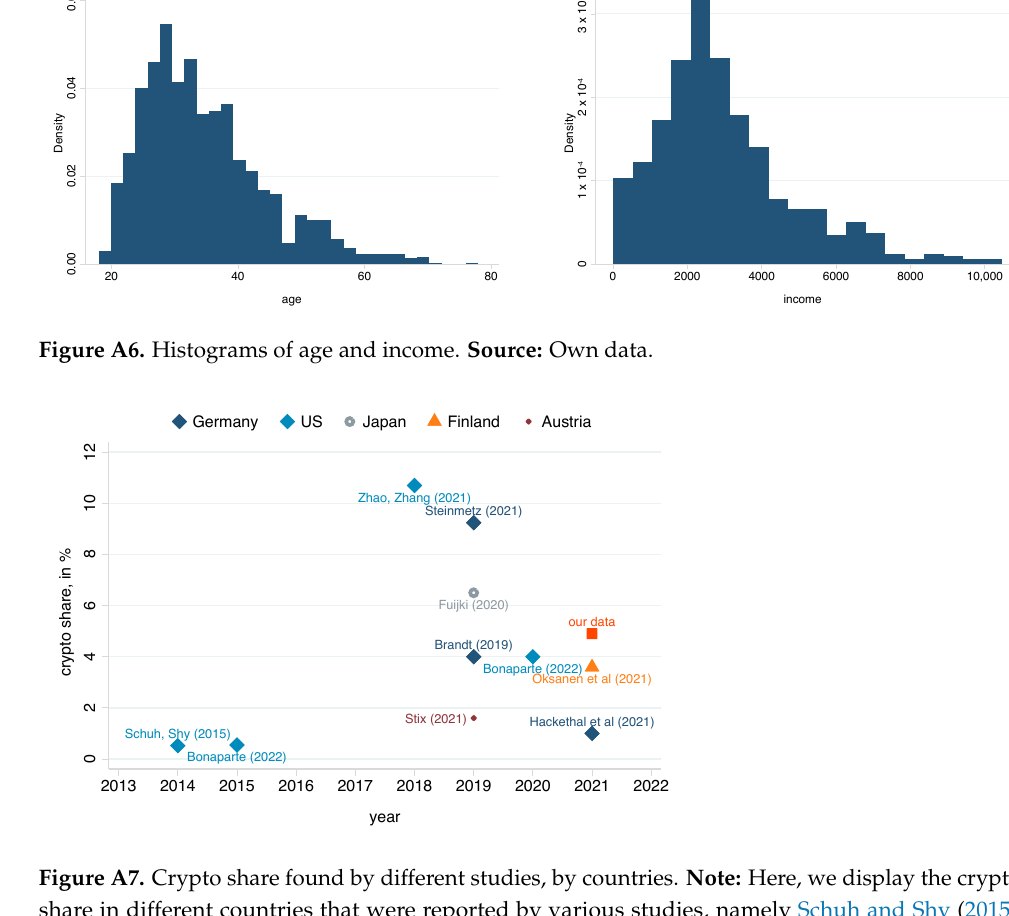
Figure A7. Crypto share found by different studies, by countries. Note: Here, we display the crypto share in different countries that were reported by various studies, namely Schuh and Shy (2015), Brandt (2019), Fujiki (2020), Hackethal et al. (2021), Steinmetz (2021), Stix (2021), Zhao and Zhang (2021), Bonaparte (2022), Oksanen et al. (2022). Source: Own